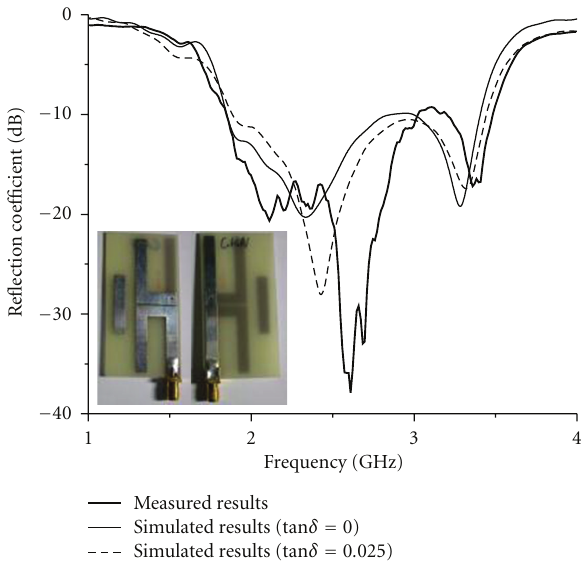
Figure 7: Simulated and experimental reflection coe ffi cient results of the printed Yagi-Uda antenna